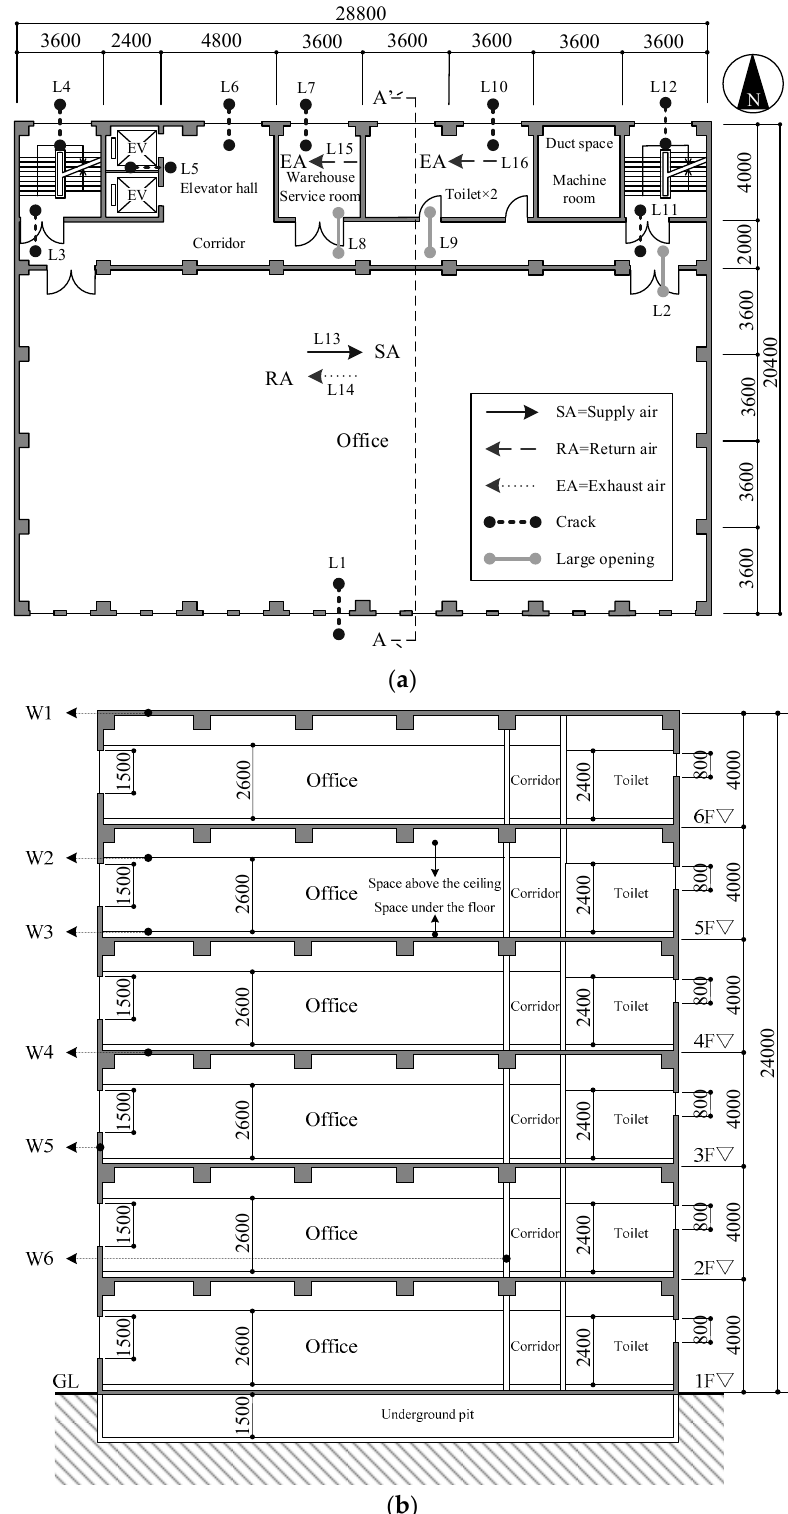
Figure 1. ( a ) Standard floor plan and airflow network of the analyzed building; ( b ) sectional view (A ‐ A’). EV = elevator shaft; Ln = air link type number; Wn = wall type number. Figure unit = mm.